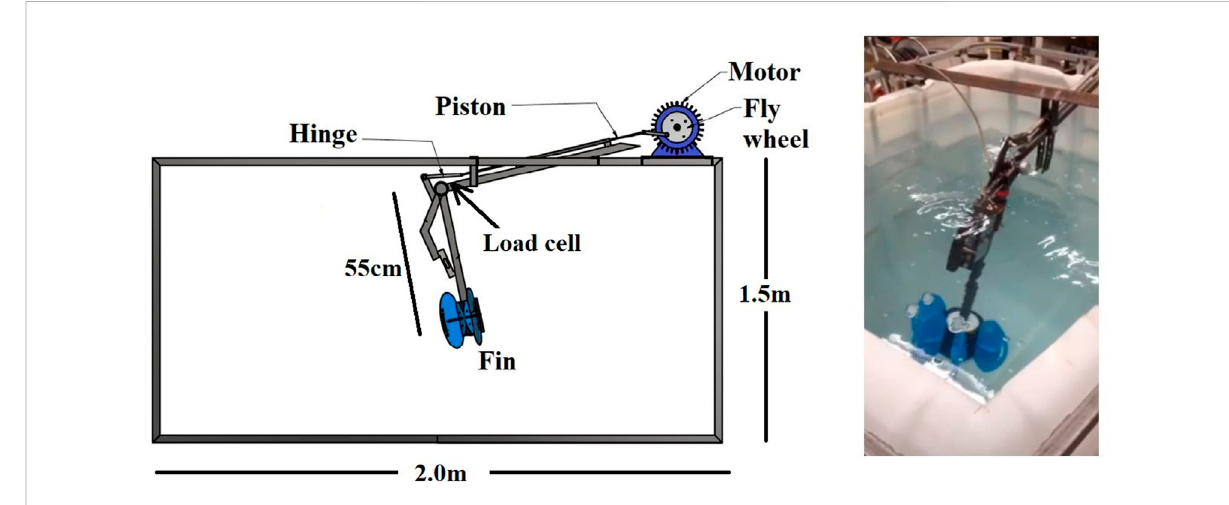
FIGURE 1 Setup of the measurement